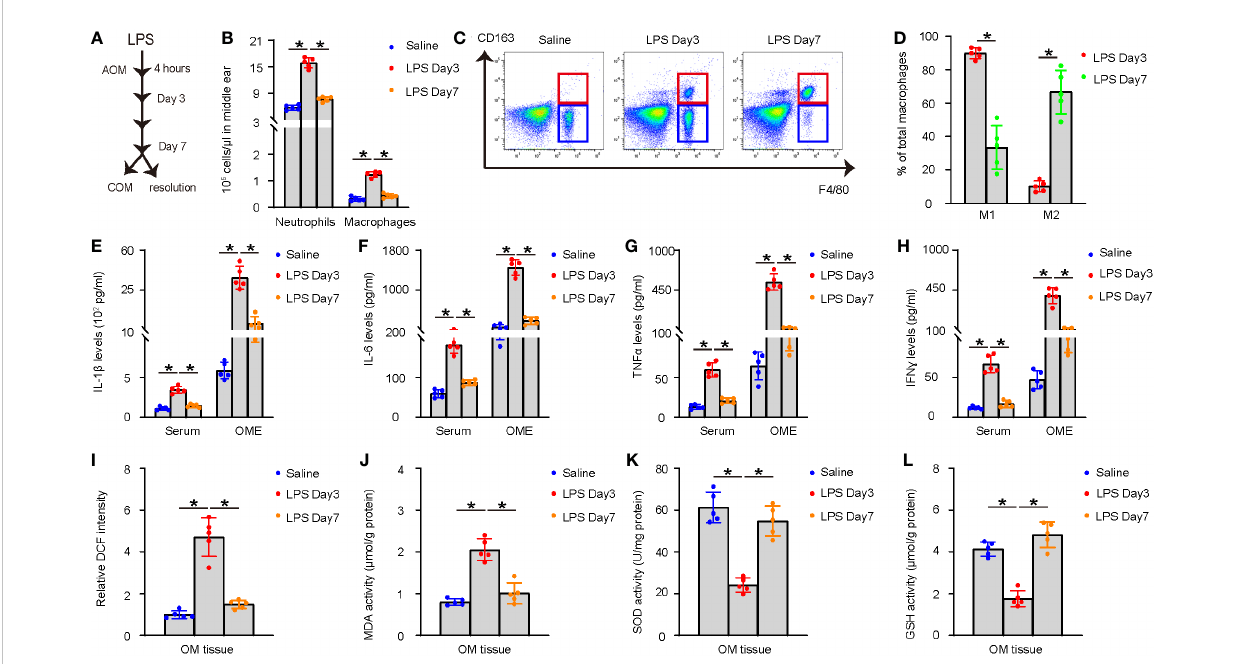
FIGURE 1 LPS injection into middle ear induces AOM in mice. (A) Schematic of the AOM model. A single high dose LPS (1.0 mg/ml) was given into the middle ear of the right ear of the mice. In this model, AOM is induced as early as 4 hours after LPS and lasts about 7 days before resolution of in fl ammation or progression into COM in a few mice. (B – D) OME was collected using myringotomy at day 3 and day 7 after LPS administration. (B) Neutrophils were manually counted. (C) F4/80+ macrophages were counted by fl ow cytometry. (D) Representative fl ow charts for analysis of macrophages